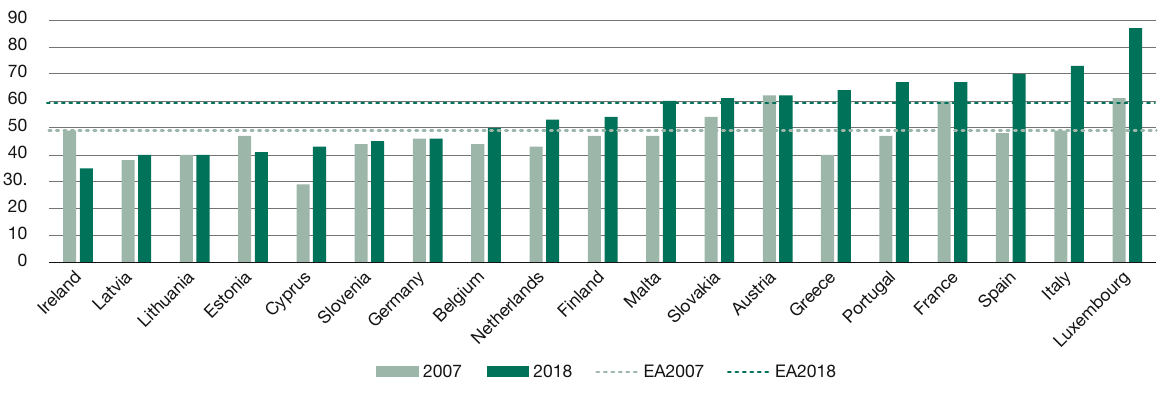
Gross replacement rates at retirement in the euro area, 2007 and 2018